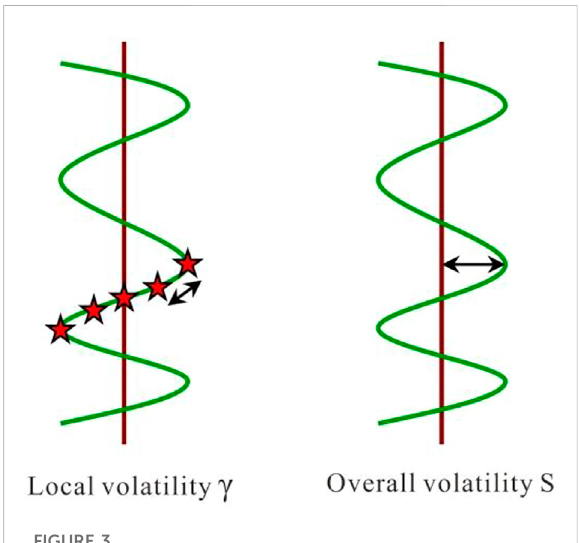
FIGURE 3 Schematic diagram of logging curve fl